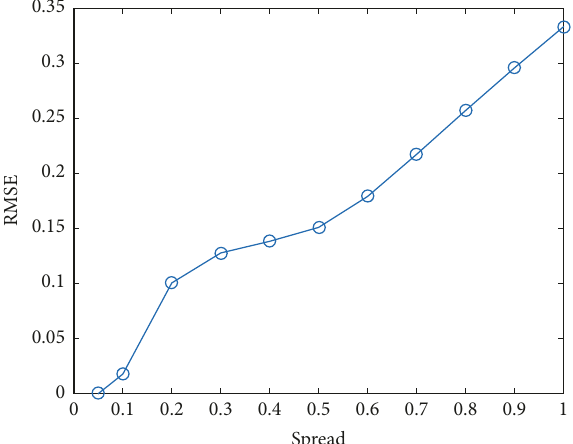
R 2 , RMSE, and MAE are 0.01, 0.066 cm, and 0.062 cm, respectively (Table 5). The worst prediction is reported with the M5Tree model with the R 2 , RMSE, and MAE being 0.10, 0.268 cm, and 0.254 cm, respectively. The slopes of the linear regression for the training and testing sets are found to be 0.97 and 0.93, respectively. The GRNN model, on the other hand, outperforms the M5Tree with small number of data sets. The slopes of linear fitting of the measured and predicted values for the training and testing phases are 1.0 and 0.95, respectively. In addition, the R 2 , RMSE, and MAE